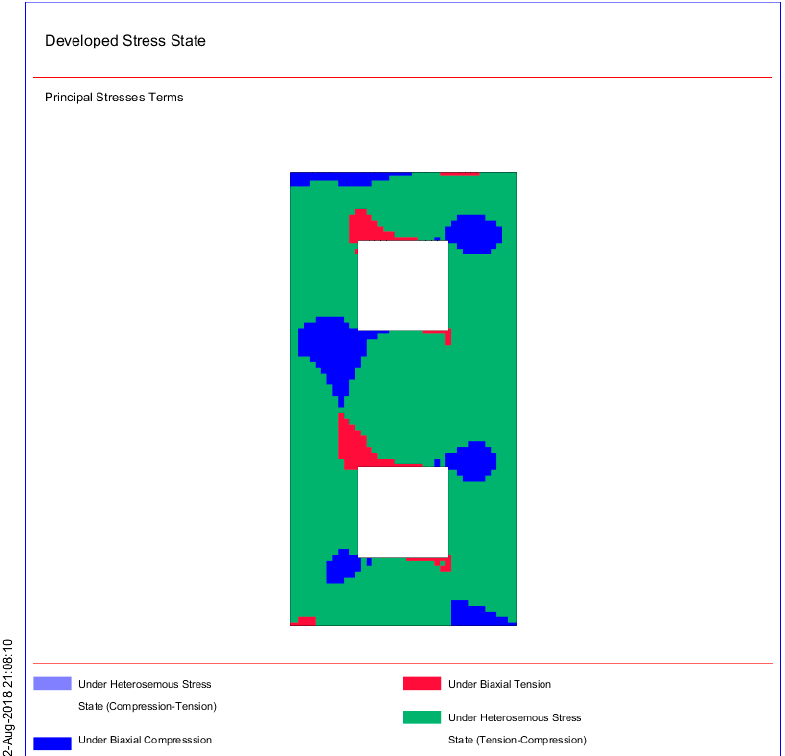
Figure 25. Developed stress state in principal stresses terms (PGA = 0.40 g).